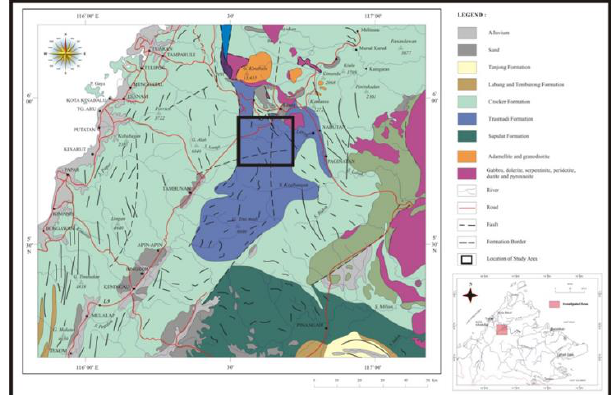
Figure 1 : Location of study area